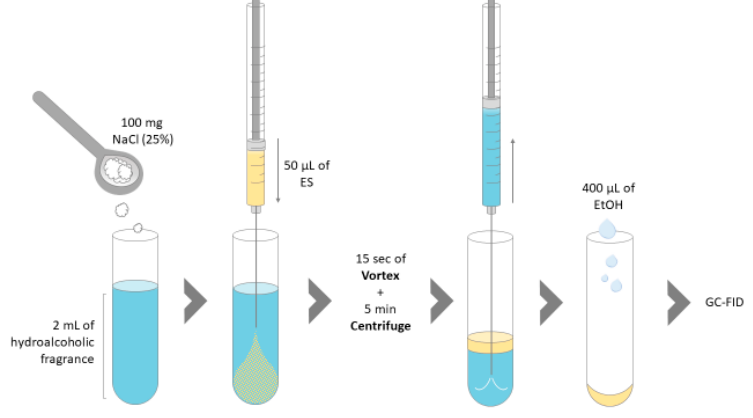
Figure 1. Scheme of the optimized HES-based DLLME method.